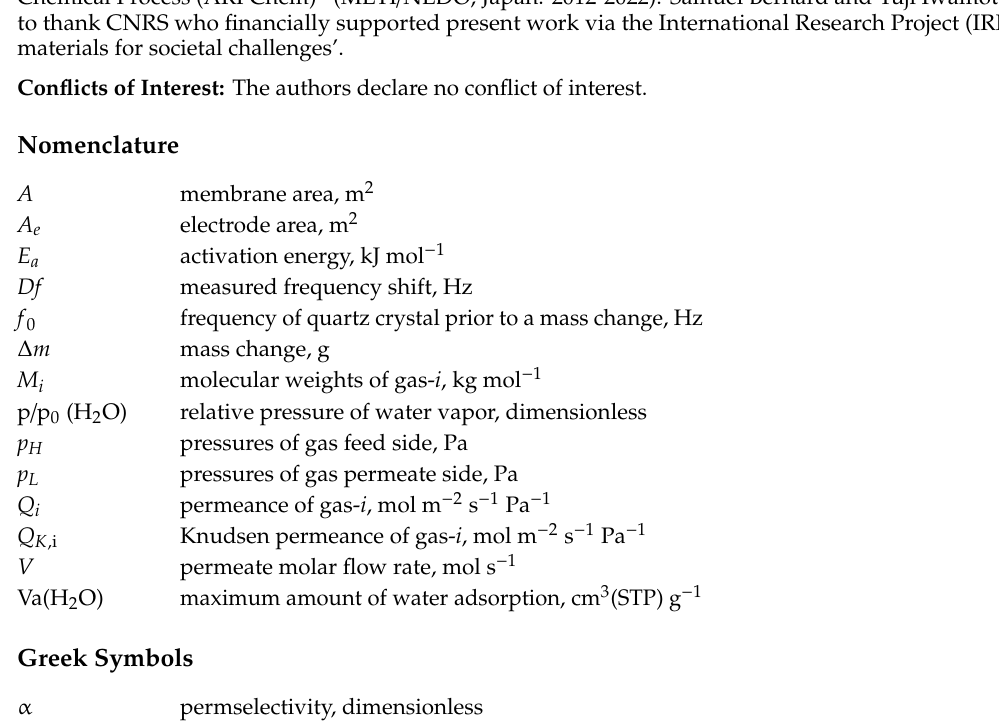
Figure S1: Structure of commercially available allyl-hydrido-polycarbosilane (AHPCS), Figure S2: Molecular weight distribution of as-received AHPCS, Figure S3: Thermal behavior of as-received AHPCS. (a) TG curve and total ion current chromatogram (TICC) under flowing He, and typical mass spectra recorded during (b) the first weight loss from100 to 250 ◦ C and (c) the second weight loss from 350 to 500 ◦ C, Figure S4: Continuous in-situ monitoring of gaseous species by mass spectrometry: (a) Fragments derived from low molecular weight fraction of as-received AHPCS during the first weight loss from 100 to 300 ◦ C and the second one from 350 to 500 ◦ C and (b) methane (CH 4 ) at 400 to 700 ◦ C. (c) Fragments suggested for gaseous spices derived from low molecular weight fraction of as-received AHPCS (Equation (1)), m / z = 42 ((CH 2 ) 3 ) from AHPCS after cross-linking via hydrosilylation between ≡ Si-H and CH 2 = CH-CH 2 -Si ≡ (Equations (2) and (3)) and m / z = 15 (CH 4 ) due to the thermal crosslinking between ≡ Si-H and ≡ Si-CH 3 groups to a ff ord ≡ Si-Si ≡ above 350 ◦ C (Equation (4)) [42], Figure S5: FT-IR spectra for as-received AHPCS and those after heat treatment at 300 to 700 ◦ C in Ar, Figure S6: Raman spectra for as-received and those AHPCS after heat treatment at 300 to 500 ◦ C in Ar. Spectra indicated the heat-treated samples were free from graphite-like carbon typically detected at 1347.5 and 1596.5 cm − 1 attributed to the D-band (for disordered graphite) and G-band (for the sp2 graphite network), respectively